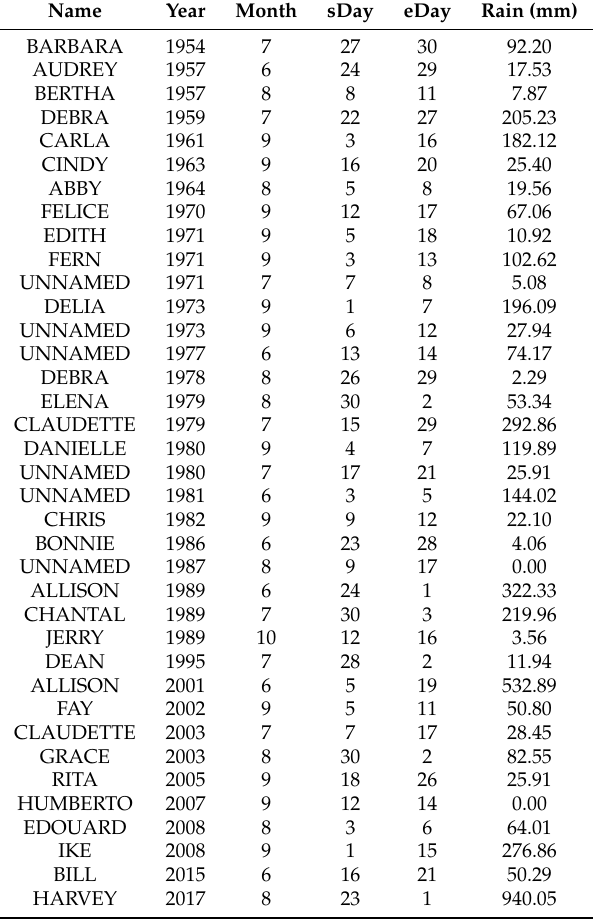
Table 1. Tropical cyclone data used for Houston, Texas. Included are the storm name, year, month, start day (sDay), end day (eDay), and accumulated rainfall in